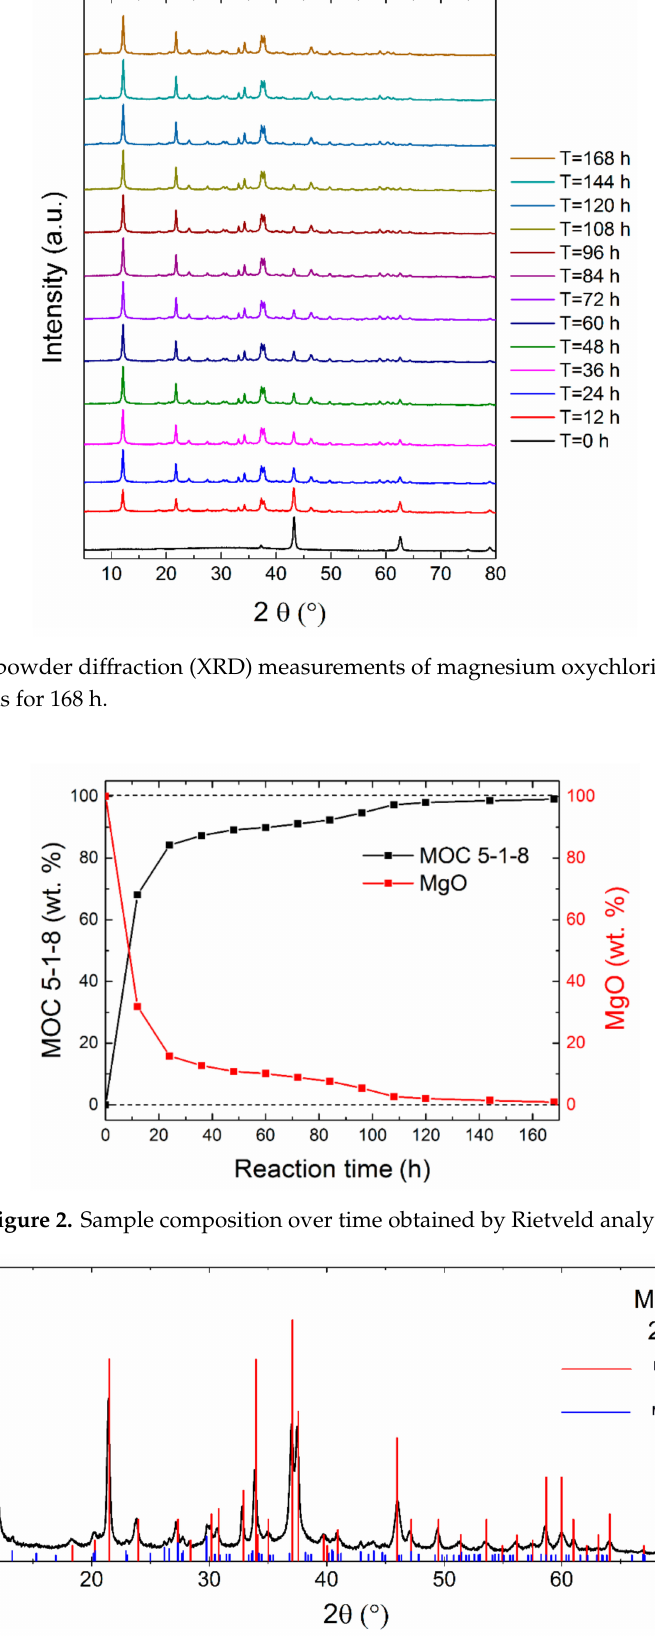
Figure 3. X-ray di ff raction pattern of MOC 5-1-8 after 28